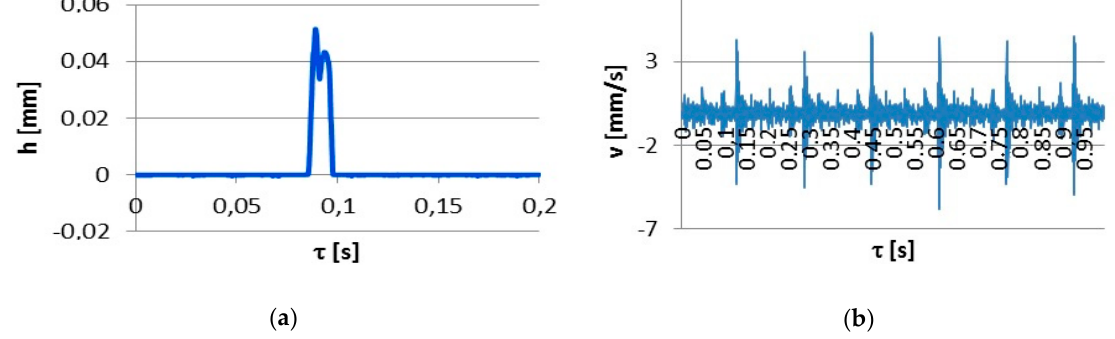
Figure 4. Sample time waveforms of the displacement vibration signal h of the injector needle for the fuel setting 70% ( a ); time waveforms of the vibration velocity signal v processed in the injection subsystem in the frequency range 0–20 kHz at a 40% relative load of engine ( b ): τ —time.